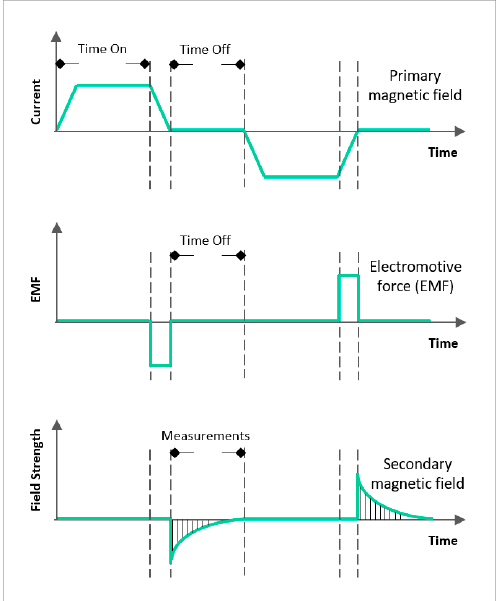
Figure 3. Time diagram in which the measurements are made by the receiver.